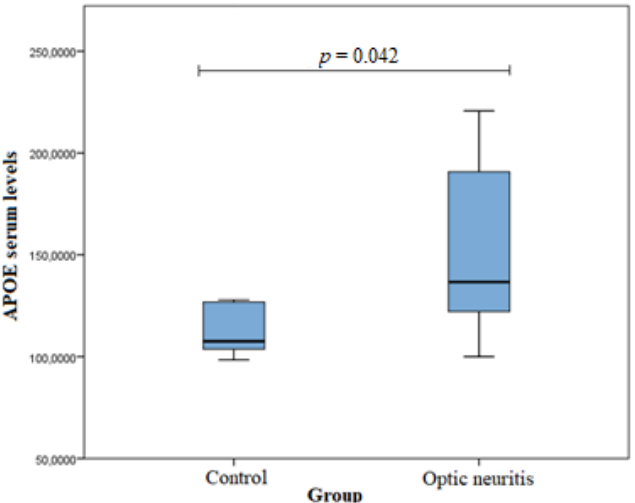
Figure 1. APOE Serum levels in control and ON groups.